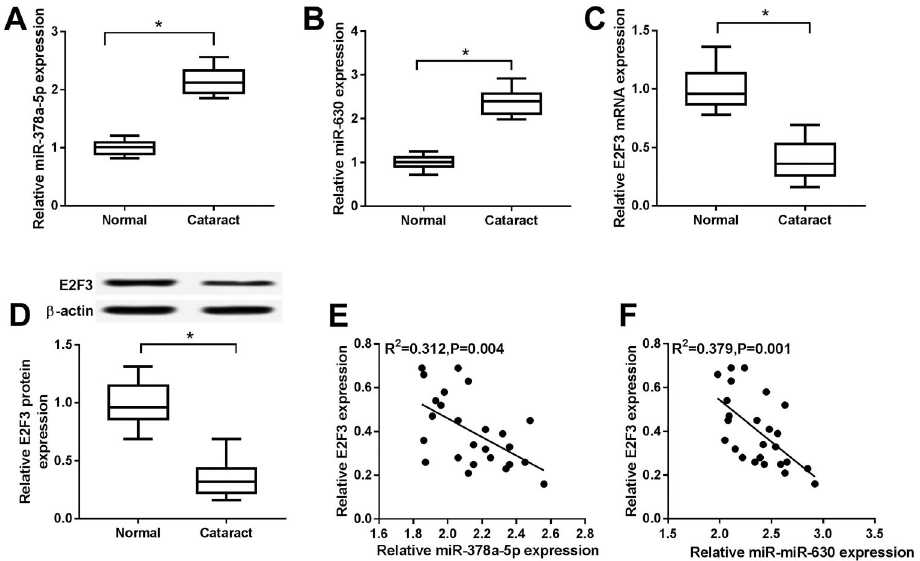
Figure 1. A and B , The expression of miR-378a-5p and miR-630 in human cataract lens tissues or the normal lens tissues was analyzed by qRT-PCR. C and D , The expression of E2F3 mRNA and protein in human cataract lens tissues and the normal lens tissues was detected by qRT-PCR and western blot. E and F , The correlation between E2F3 and miR-378a-5p or miR-630 was determined by Pearson ’ s correlation coef fi cient analysis. Data are reported as median and interquartile range. *P o 0.05 (one-way ANOVA followed by Tukey's